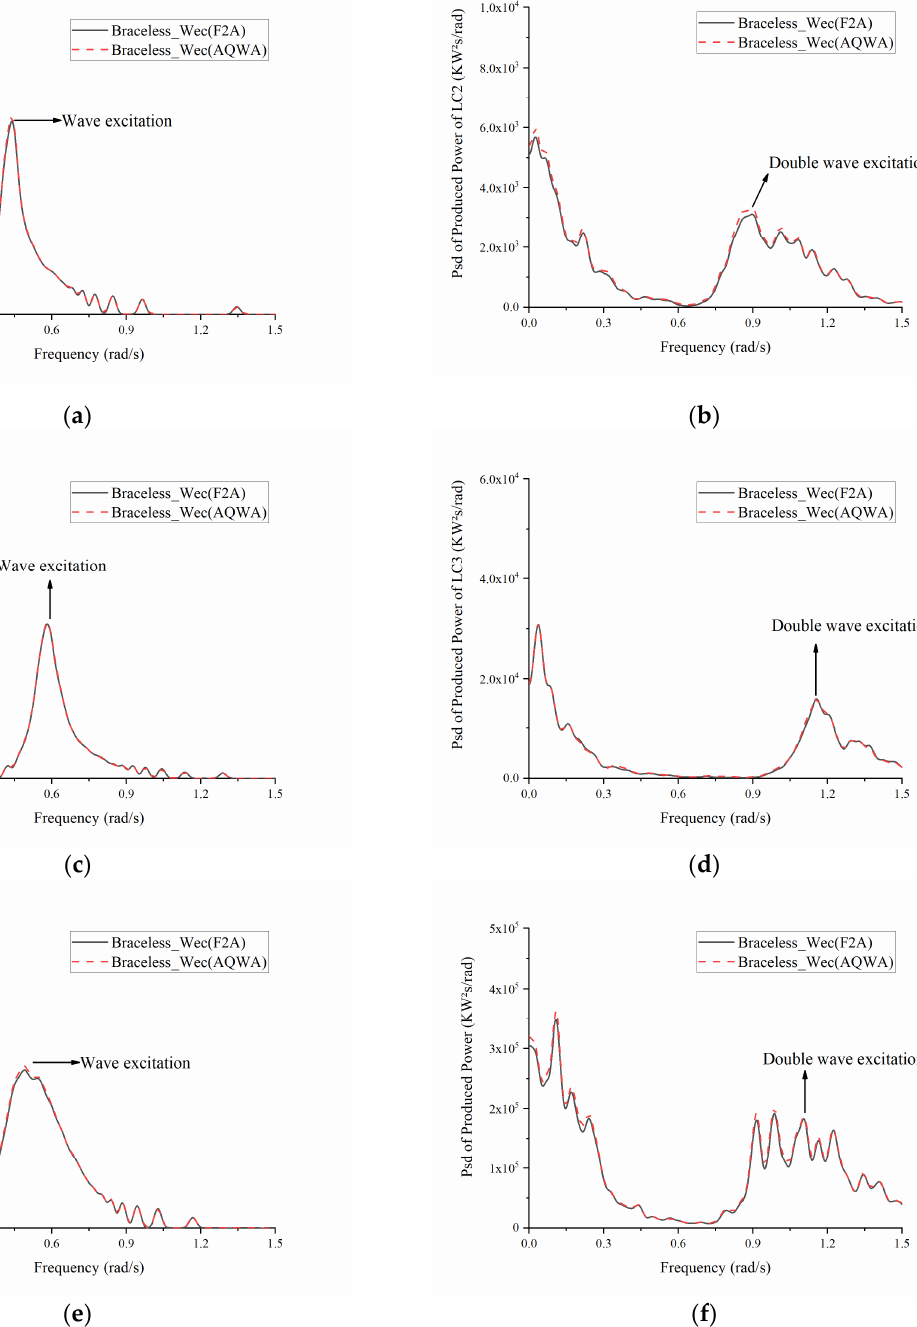
Figure 15. Comparisons of the PSD of: ( a ) Damping Force of LC2; ( b ) Produced Power of LC2; ( c ) Damping Force of LC3; ( d ) Produced Power of LC3; ( e ) Damping Force of LC4; ( f ) Produced Power of LC4.